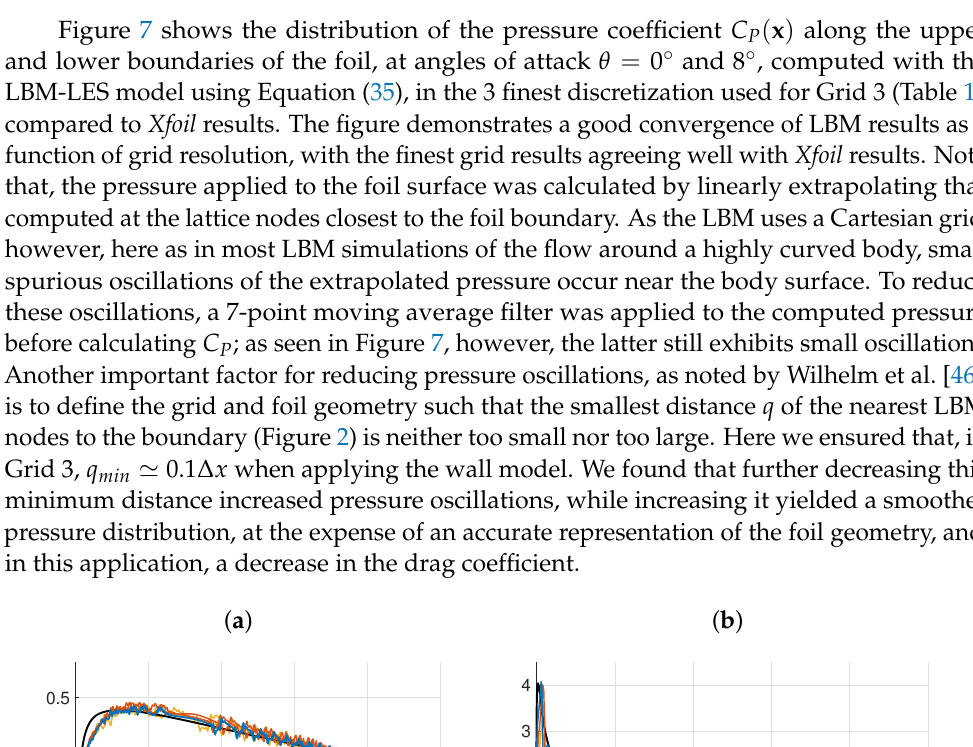
Figure 6. LBM-LES simulations of ( a ) lift, and ( b ) drag coefficient for a NACA-0012 foil profile, as a function of the angle of attack θ , for Re = 1.44 × 10 6 with a Grid 3 resolution ∆ x / C (Table 1): ( • ) 4.0 × 10 − 3 , ( • ) 3.5 × 10 − 3 , ( • ) 3.0 × 10 − 3 , and ( • ) 2.5 × 10 − 3 .; compared to: ( (cid:5) ) Xfoil results and measurements by [43] for Re = 1.44 × 10 6 , for rough ( — ) and smooth (- - -) foils, and [44] at Re = 1.36 × 10 6 , for a smooth foil ( – - – ).